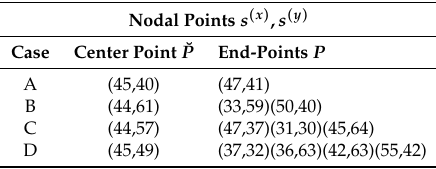
Table 5. Coordinate of the block s ( x ) , s ( y ) enclosed end-point set for multilateral well, PSO algorithm. Nodal Points s ( x ) , s ( y